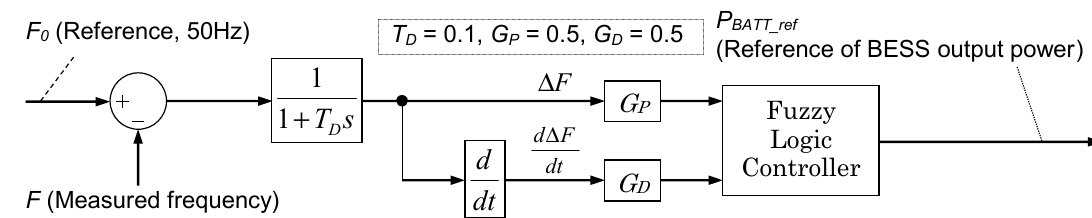
Figure 10. Active power controller of the battery energy storage system (BESS).